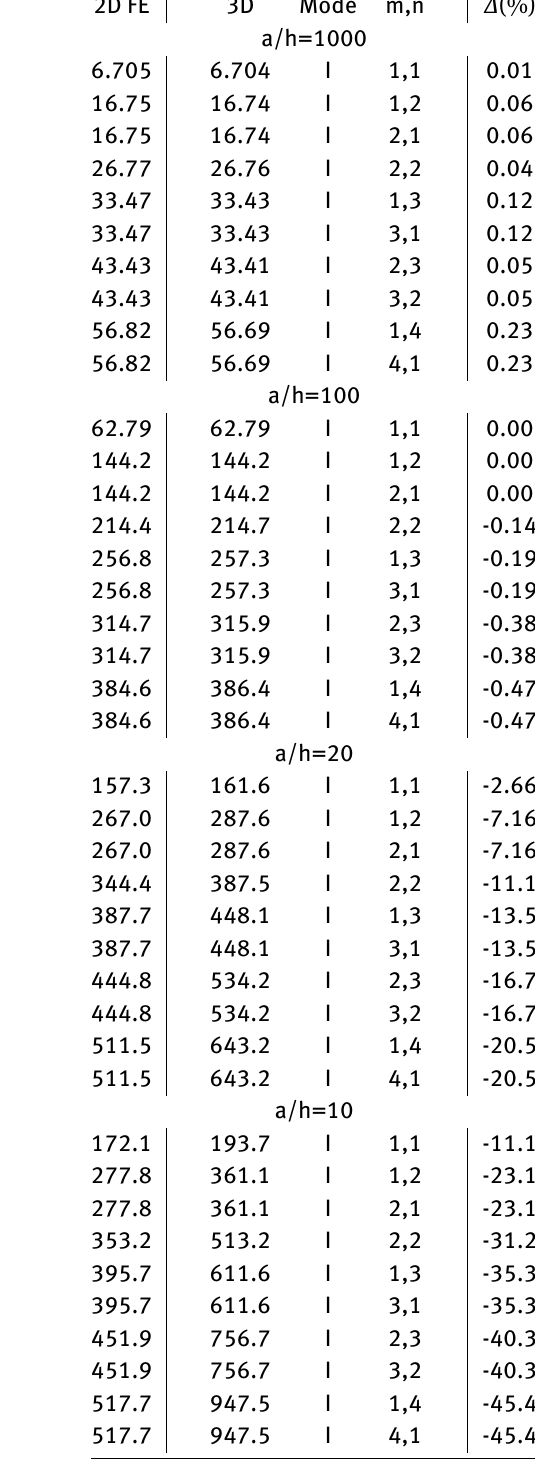
Table 17: Tenth benchmark, simply supported composite cylin- der 90 ∘ /0 ∘ /90 ∘ /0 ∘ with thickness ratios R α /h=1000, R α /h=100, R α / h = 10 and R α /h=5. First ten frequencies in Hz, comparison between the present 3D exact solution and the 2D FE solution via